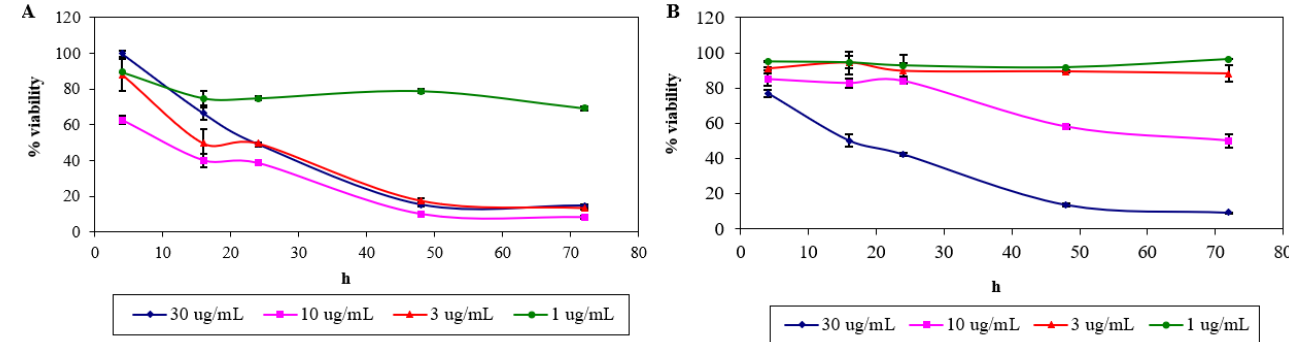
Figure 2. The percentage of viability (relative to control) of T-lymphoblastic leukaemia (CEM-SS) cells treated with different concentrations of nordamnacanthal ( A ) and damnacanthal ( B ) for a 72 h period, determined using the MTT assay. Control cultures were not treated with nordamnacanthal or damnacanthal. Each data point represents the mean of three independent experiments, and vertical lines through the data points indicate standard deviation.